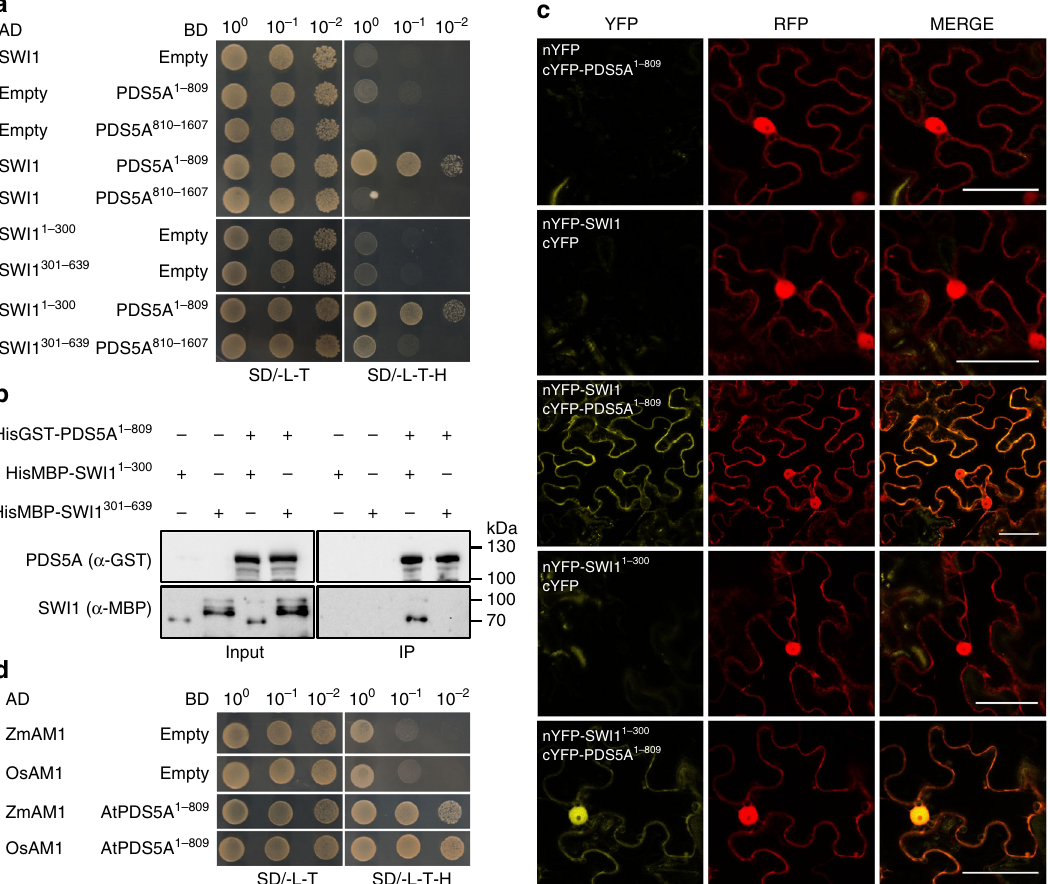
Fig. 3 SWI1 interaction with cohesin components. a Yeast two-hybrid interaction assay of SWI1 with PDS5A. SWI1 and PDS5A were divided into an N-terminal part (SWI 1-300 , PDS5A 1-809 ) and a C-terminal part (SWI 301 – 639 , PDS5A 810-1607 ). Yeast cells harboring both the AD (activating domain) and BD (binding domain) were grown on synthetic medium supplied with dextrose (SD) in the absence of Leu and Trp (SD/ -L -T, left panel) and on SD medium in the absence of Leu, Trp, and His (SD/ -L -T -H, right panel). Yeast cells were incubated until OD 600 = 1 and then diluted 10- and 100-fold for assays. b Co-immunoprecipitation assay of SWI1 with PDS5A. HisGST-PDS5A 1-809 -bound or unoccupied agarose beads were incubated in the presence of HisMBP-SWI1 1-300 and HisMBP-SWI1 301-639 . The pull-down fractions were analyzed by immunoblotting with anti-GST (upper panel) and anti-MBP (lower panel) antibodies. The source data of the uncropped immunoblots are provided in the Source Data fi le. c Interaction of SWI1 with PDS5A using bimolecular fl uorescence complementation (BiFC) assays. YFP fl uorescence indicates a successful complementation and hence interaction of the proteins tested. RFP is used as an indicator for the successful Agrobacterium in fi ltration. d Yeast two-hybrid interaction assay of SWI1 homologs in maize (ZmAM1) and rice (OsAM1) with Arabidopsis PDS5A